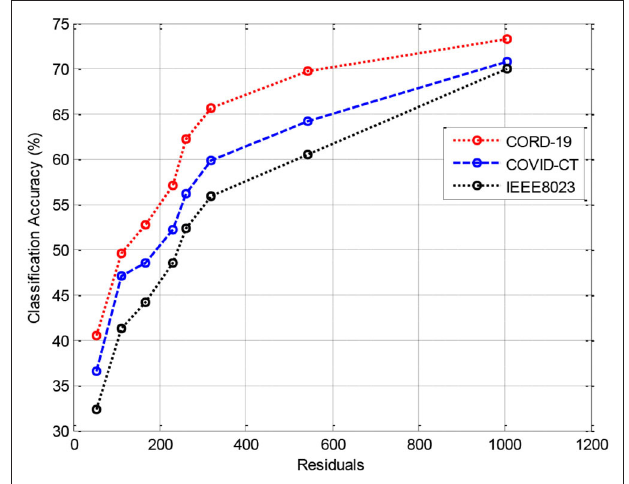
FIGURE 5 | Results of classification accuracy during training with 90% training